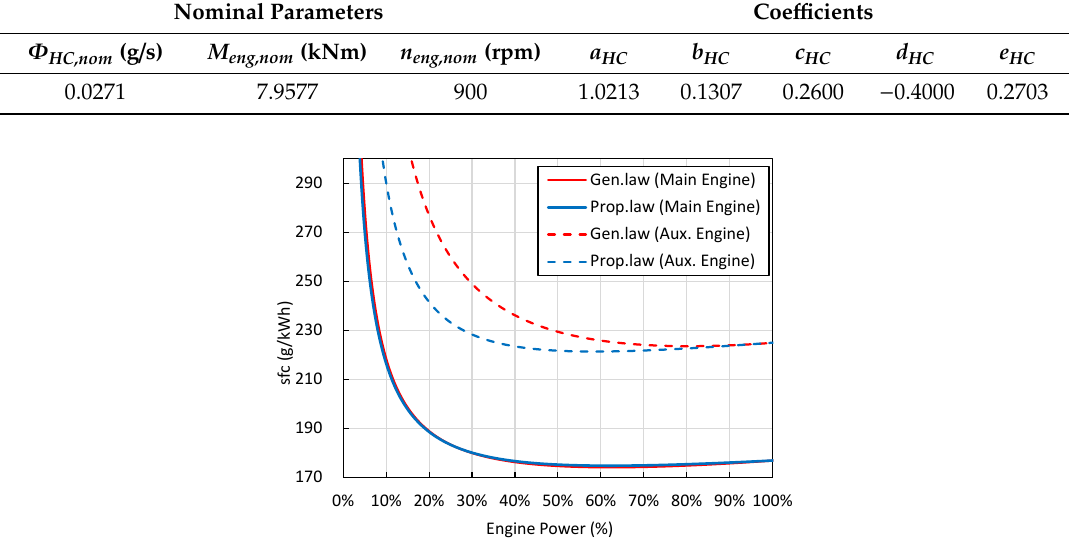
Figure A3. Specific fuel consumption of main engine and auxiliary engines.